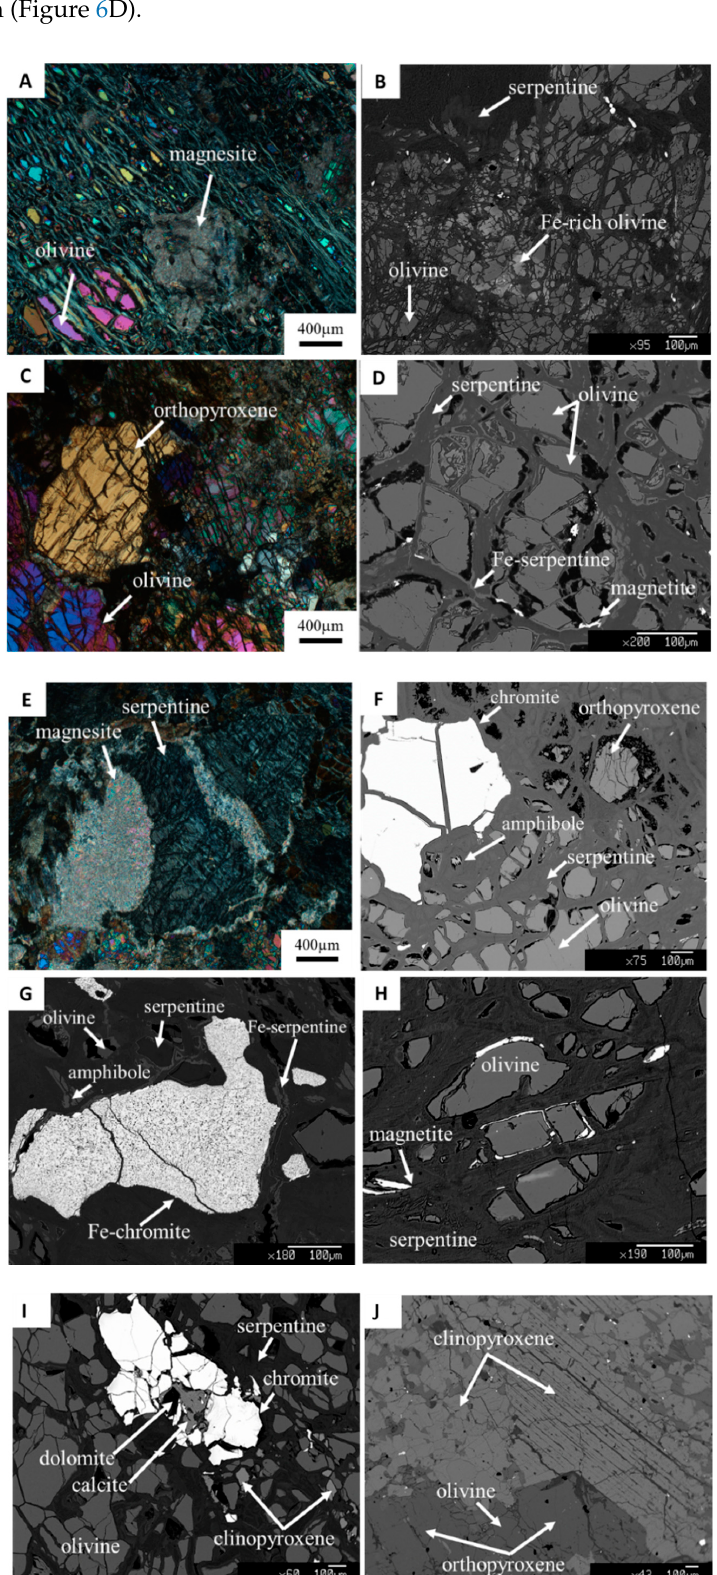
Figure 5. Optical microscopy (crossed polars; ( A,C,E )) and back-scattered images ( B,D,F,G,H,I,J ) of serpentinized peridotites from the Rachoni mine (from samples W6, W13, W14, W15, W16).